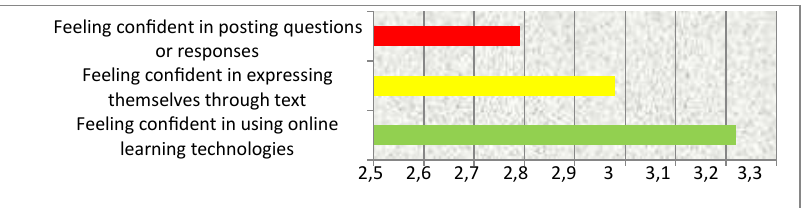
Figure 6. Students’ Online Communication